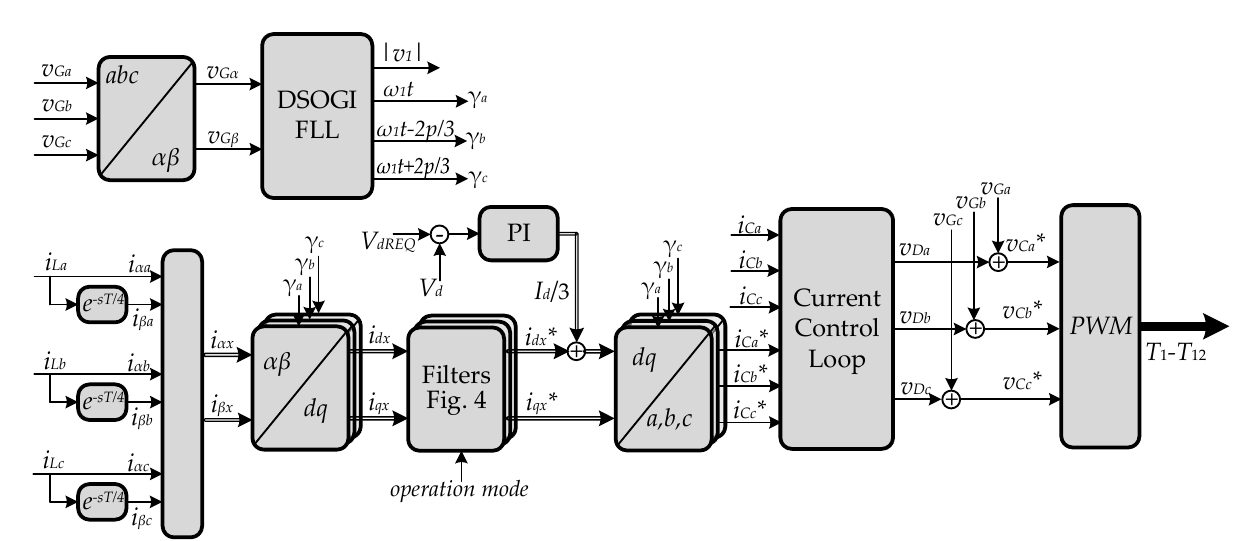
Figure 5. Control system of the presented active power filter.